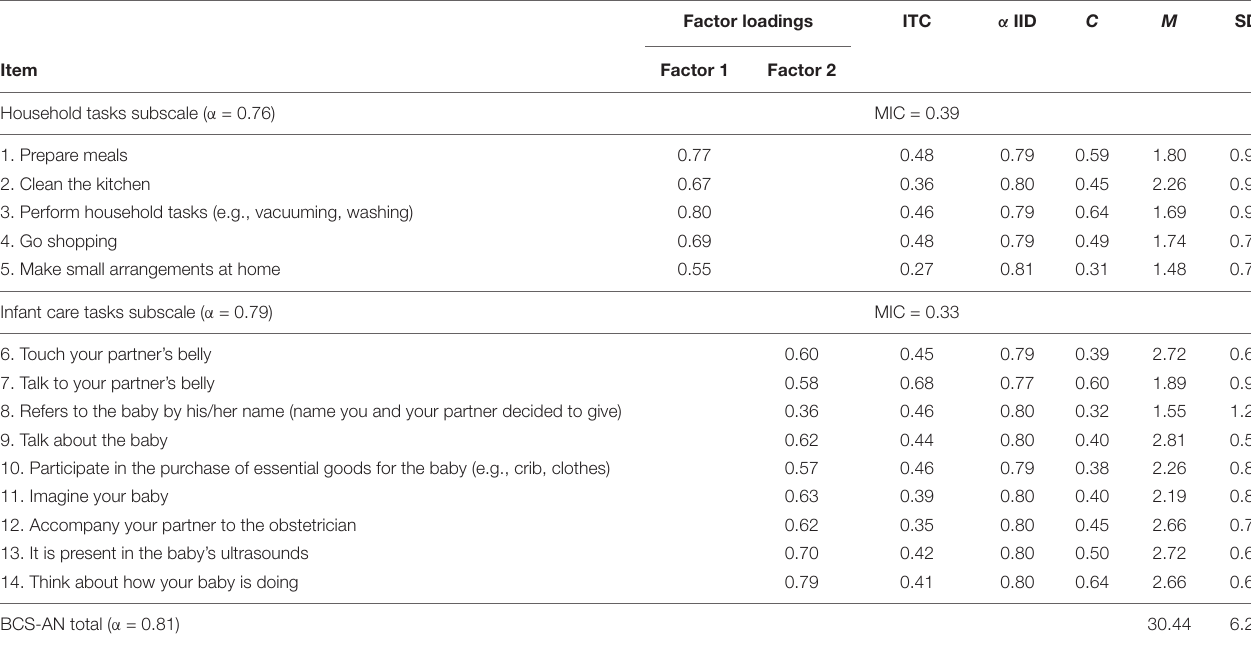
TABLE 2 | BCS-AN exploratory factor analysis.